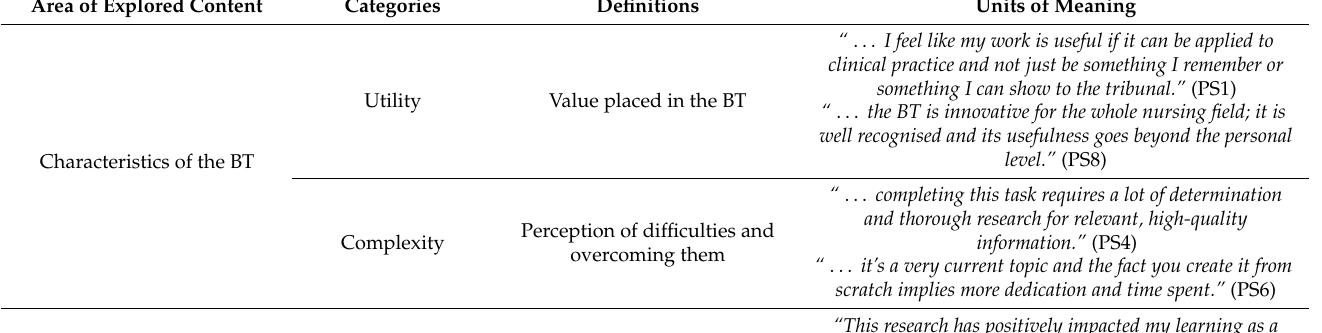
Table 2. Qualitative results matrix, Level 1 (participant student: PS).